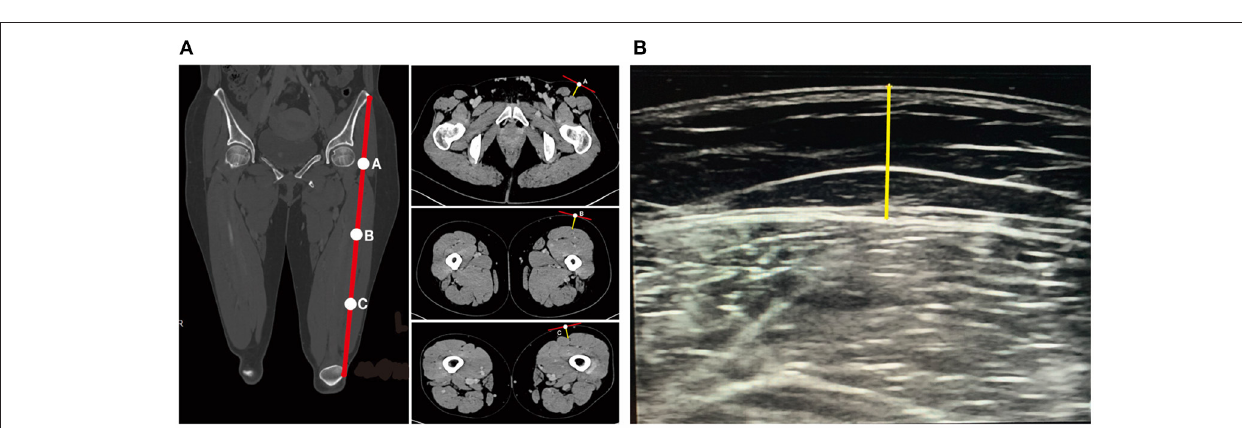
FIGURE 1 | Schematic diagram of the selected marker points to measure the ALT flap thickness.